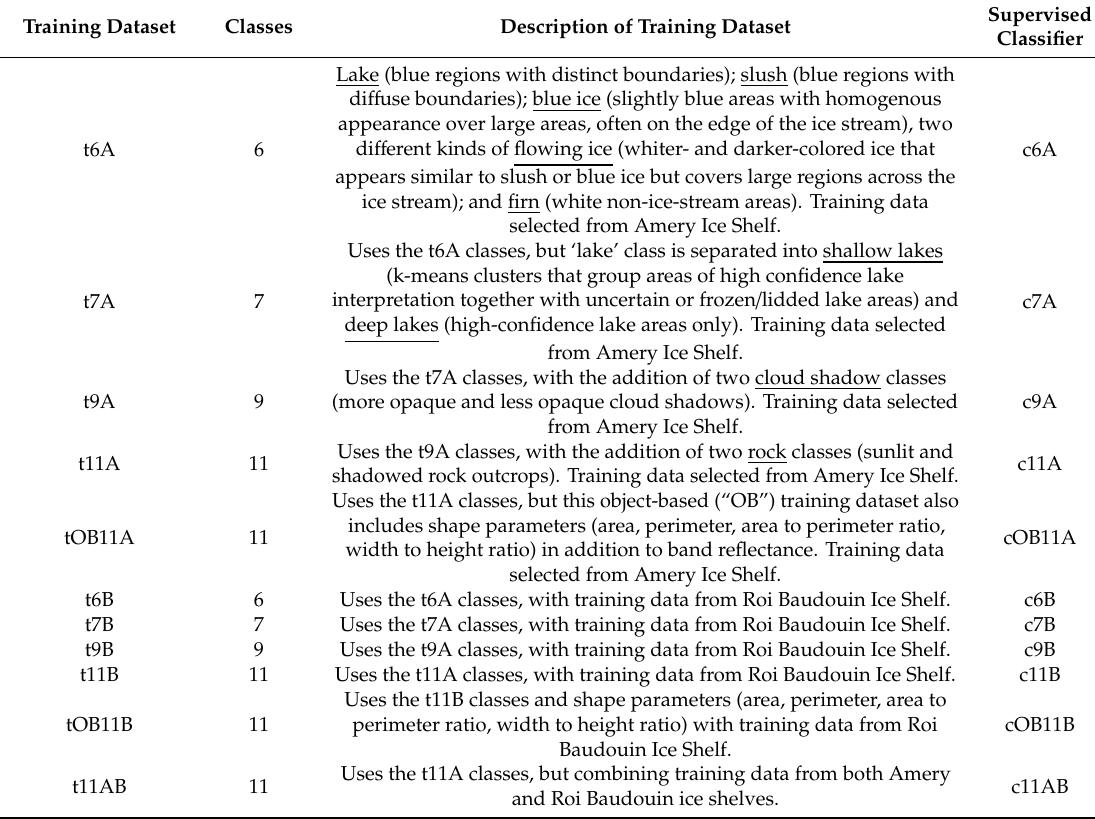
Table 1. Names and descriptions of training datasets. The corresponding trained supervised classifiers are generated using each training dataset as input to a Random Forest classification